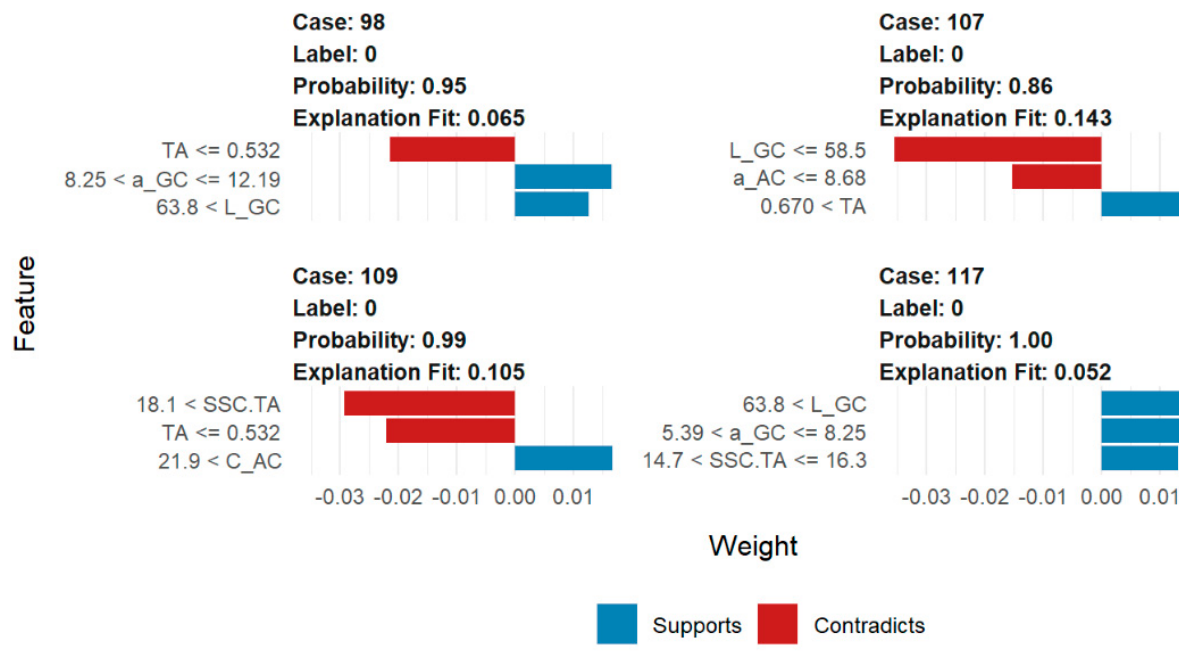
Figure 2. A few random LIME predictions on the Model A dataset. (Due to the inability to use special characters in the programming language, feature names are slightly modified, as described in Appendix A . )